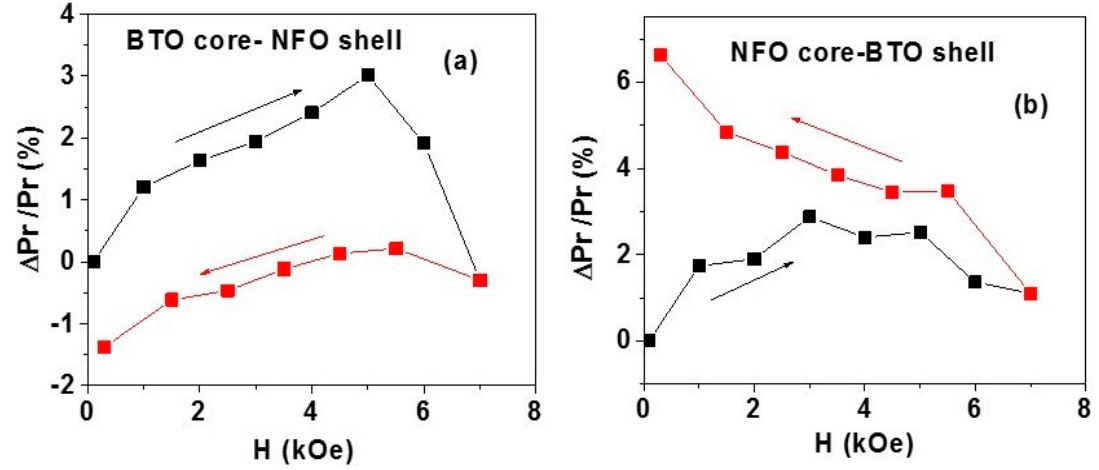
Figure 4. The fractional change in the remnant polarization as a function of static magnetic field H for discs of magnetic field-oriented annealed fibers of ( a ) sample A and ( b ) sample B.